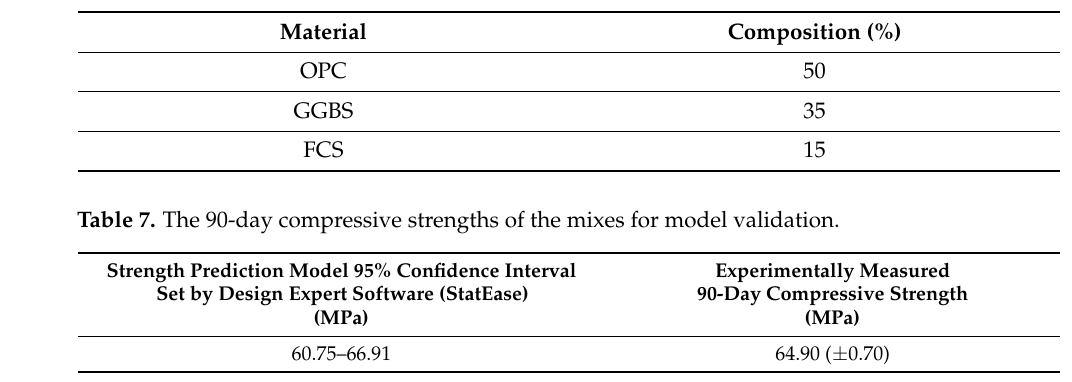
Table 6. Mix composition for model validation.